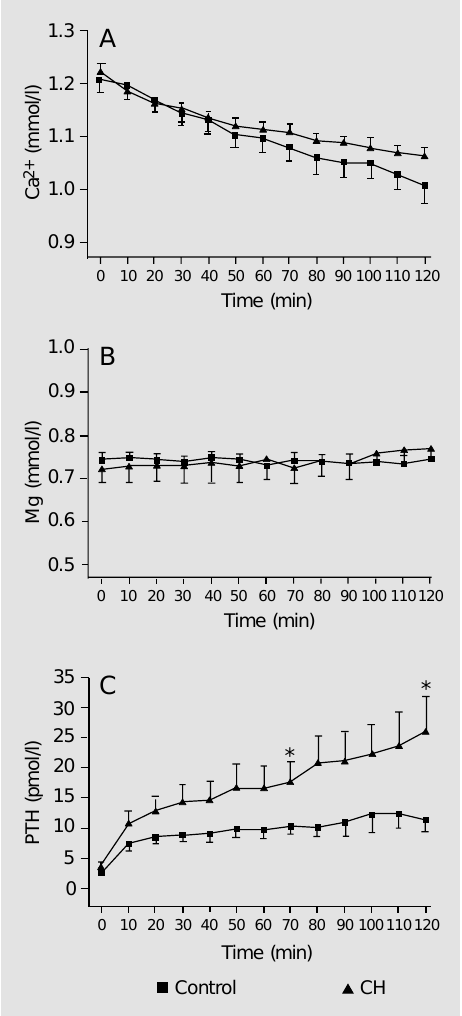
Figure 1. Test of parathyroid hormone (PTH) stimulation in hypercortisolism. Blood calcium (A), magnesium (B), and PTH concentrations (C) of patients with chronic hypercortisolism (CH) and normal subjects (con- trols), before (time -30, -20, -10, 0) and for 2 h after EDTA infu- sion (30 mg/kg weight). Data are reported as means ± SEM. *P<0.05 compared to controls (Mann-Whitney